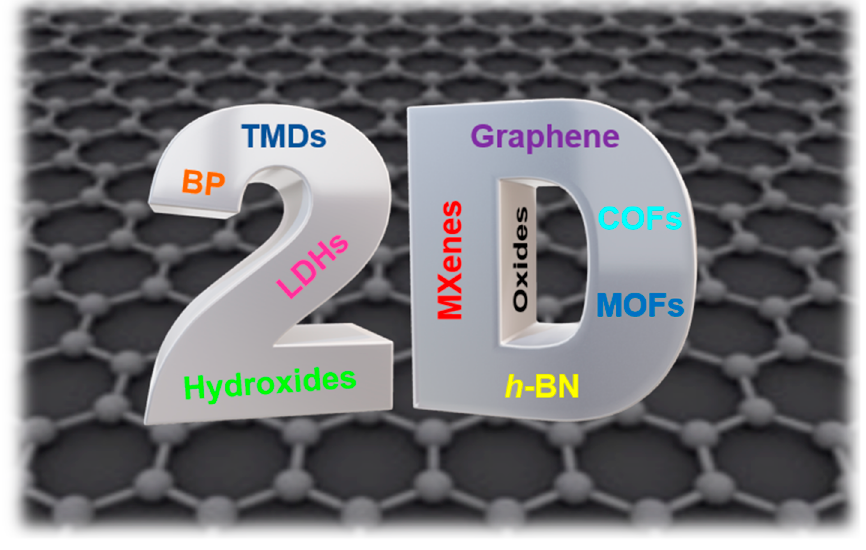
Figure 20. A graphical presentation of different types of ultrathin 2D nanomaterials.